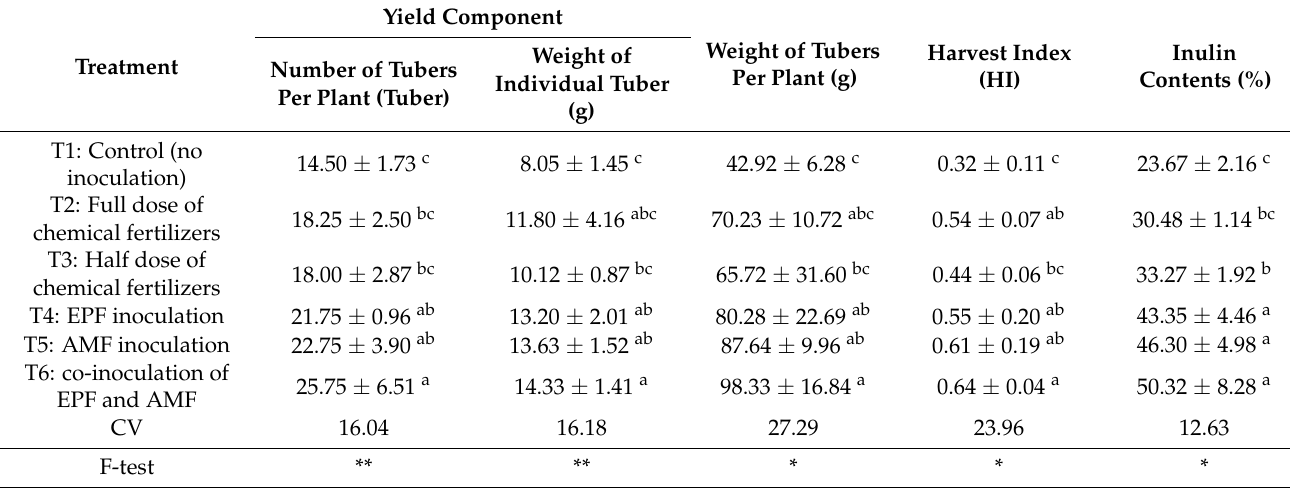
Table 4. Tuber yield, number of tubers, tuber size, harvest index (HI), and tuber inulin contents of sunchoke at the harvest stage (120 days after planting) under field